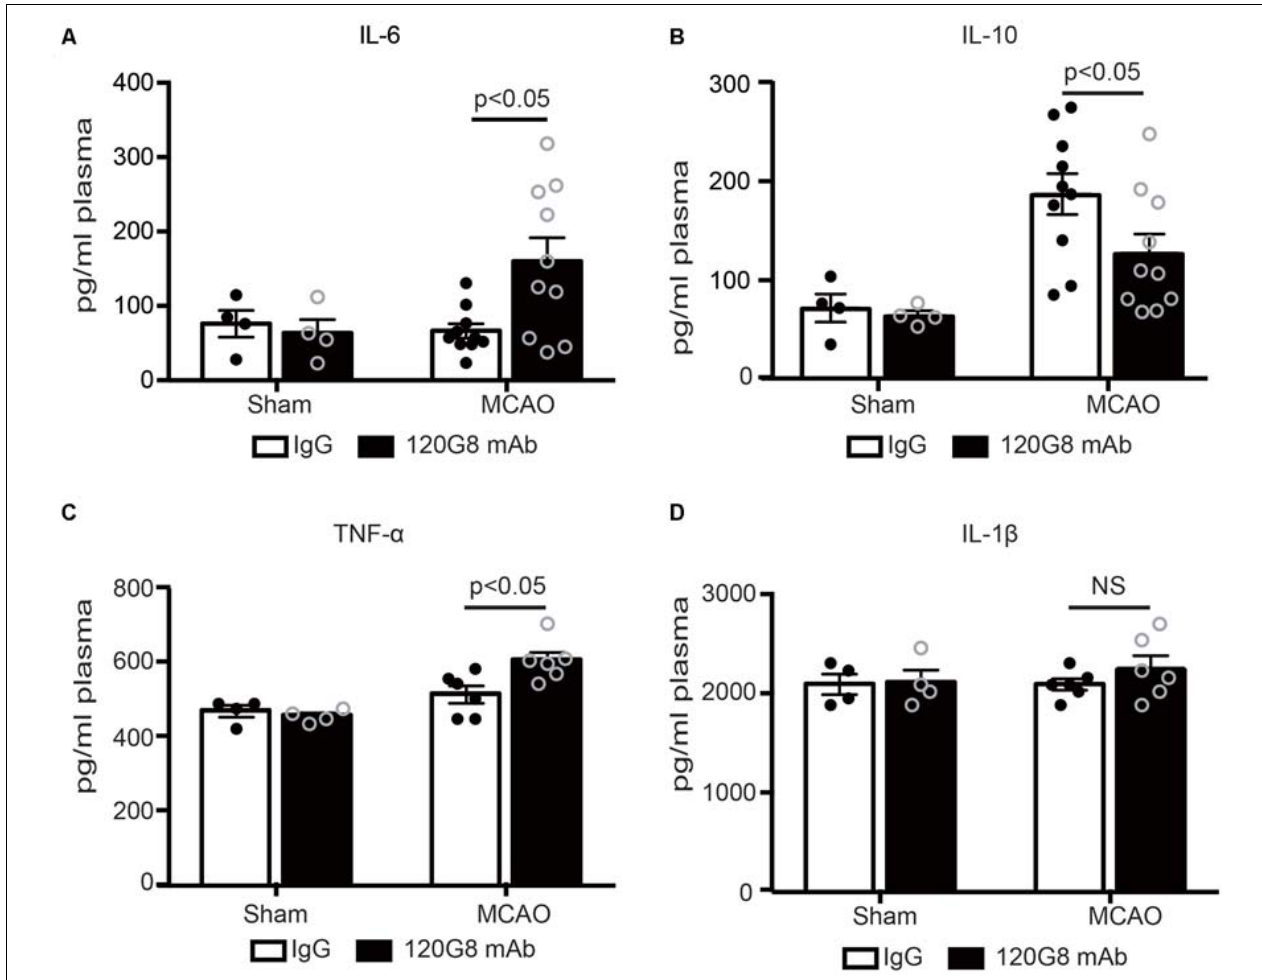
FIGURE 3 | Depletion of pDCs accelerates the peripheral pro-inflammatory response followed by MCAO. One-hundred micrograms 120G8 mAb or rat IgG i.p injection was conducted immediately before MCAO or sham procedure in mice. Cytokines in the plasma from each group were detected with ELISA. (A) Statistical analysis of IL-6 expression. (B) Statistical analysis of IL-10 expression. (C) Statistical analysis of TNF- α expression. (D) Statistical analysis of IL-1 β expression. Data are expressed as means ± SEM for n = 4–10 mice per group. The scatter plots represent independent samples. NS: no